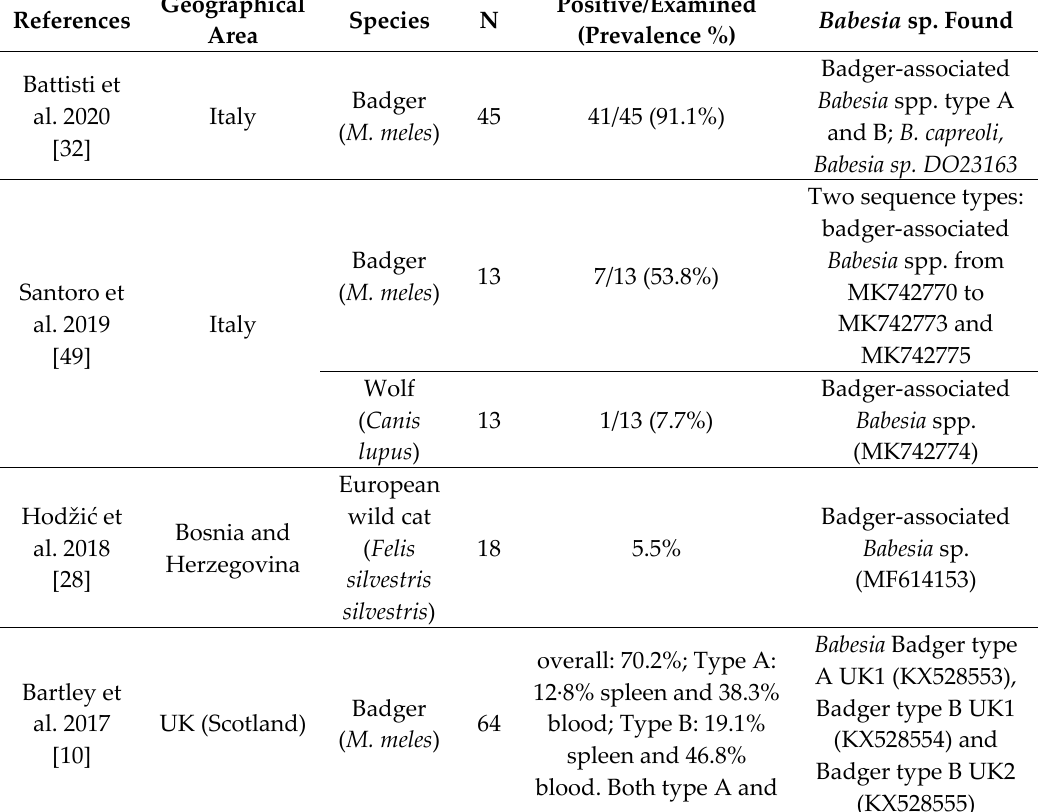
Table 2. Literature studies (since 2009) that report badger ‐ associated Babesia sp. in Eurasian badgers ( Meles meles ) or in other carnivore species or